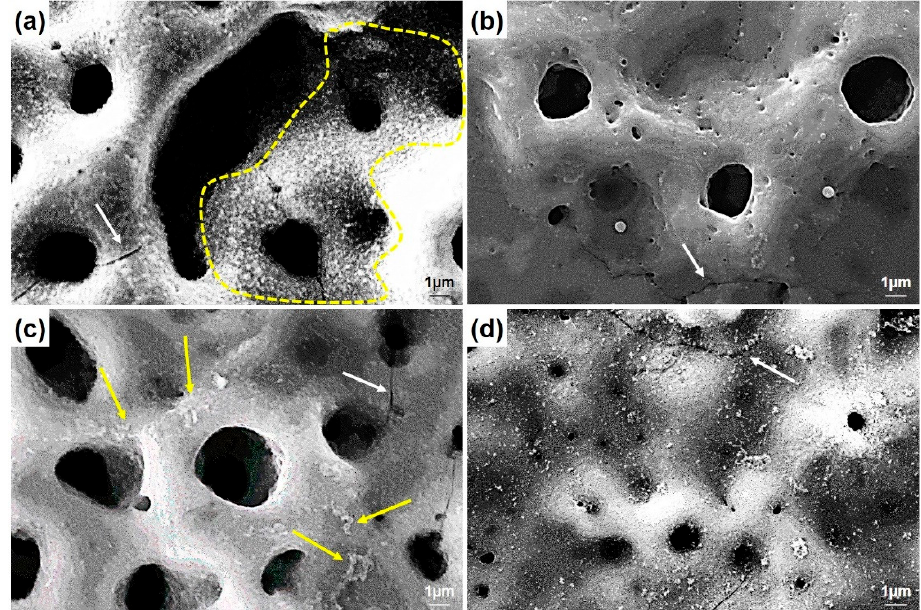
Figure 4. The SEM morphologies of PEO treated coatings with ( a ) free GNS, ( b ) 0.5, ( c ) 1.0, and ( d ) 1.5 wt% GNS additive at higher